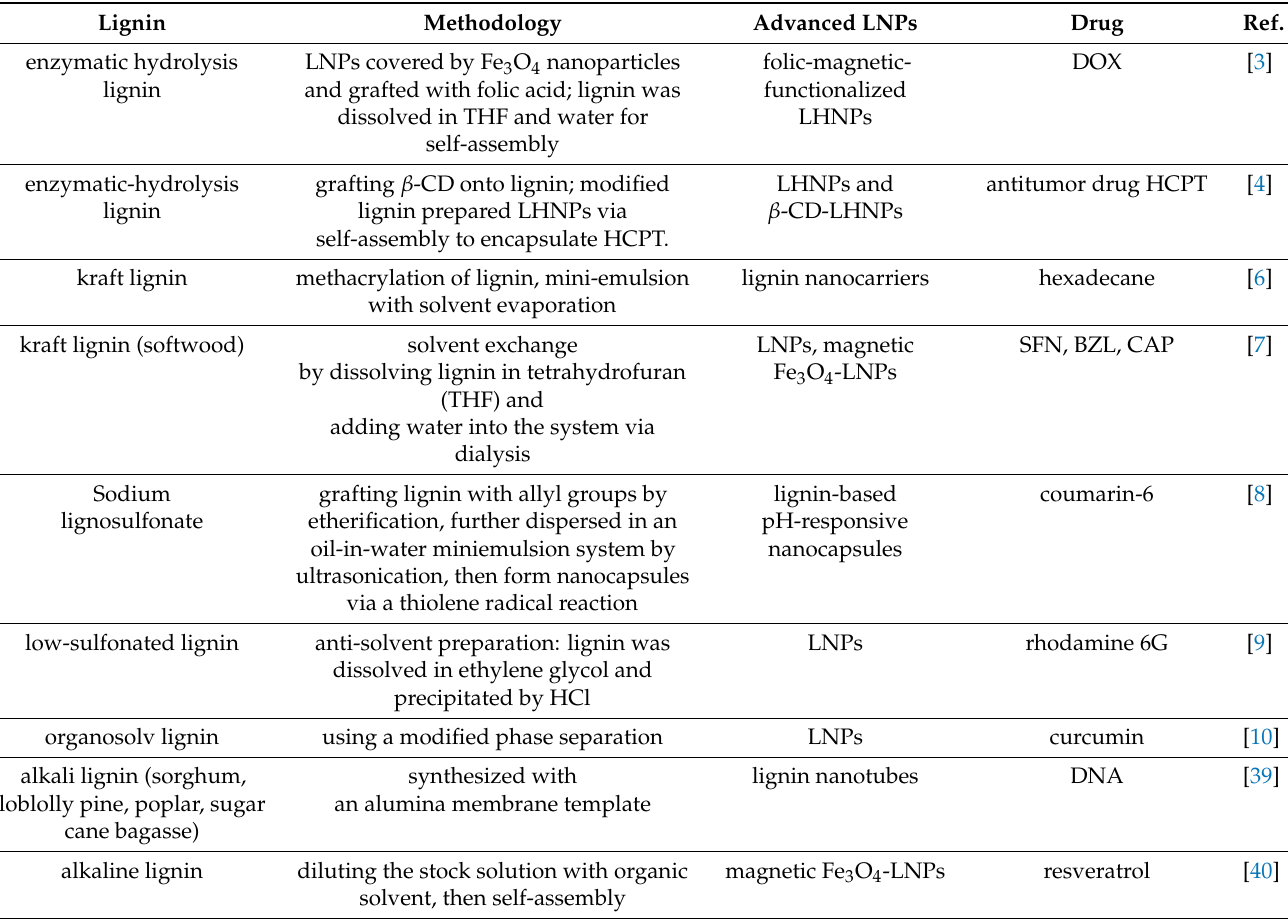
Table 2. Literature overview of lignin-based nanoparticles (LNPs) and their applications in drug